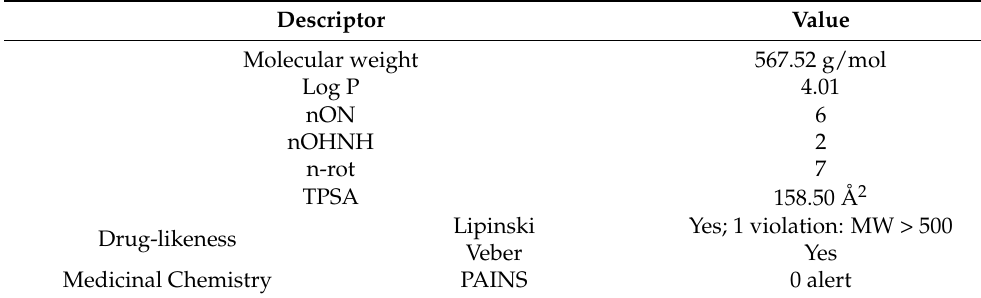
Table 3. In silico molecular properties of bis-thiobarbiturate 11 using the SwissADME predictive database a .